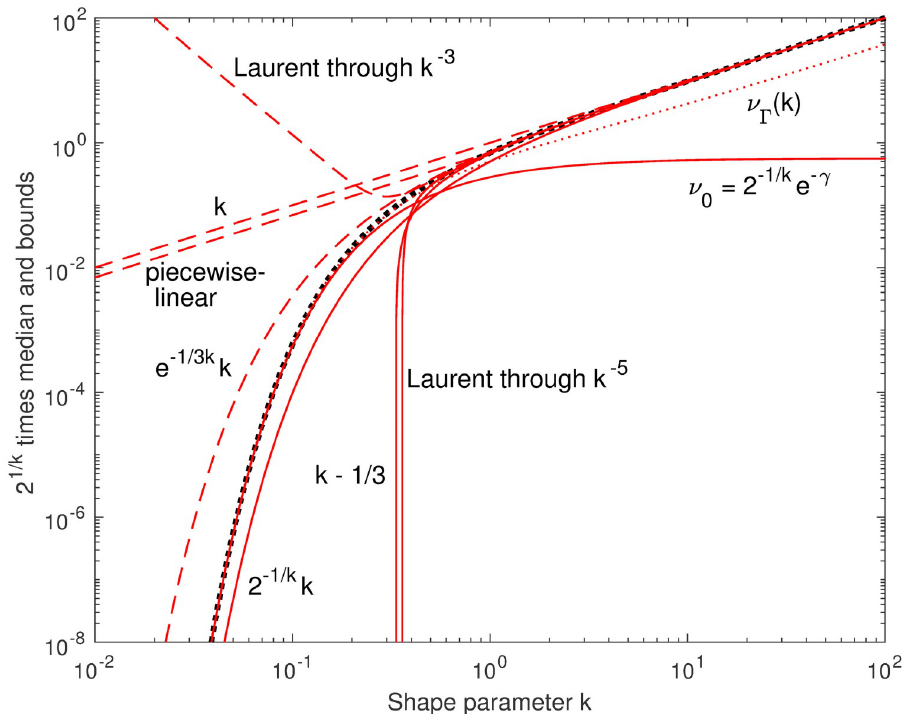
Fig 2. Previously known bounds. Previously published bounds (lower bounds solid, upper bounds dashed) for the median of a gamma distribution (heavy dotted), are good at high k or low k , but not both. At the left, at k = 0.01, the median is near 10 − 30 . Only ν 0 ( k ) is close at low k , and it was published as an asymptote, but not a bound; it is strictly less than our new lower bound ν Γ ( k )